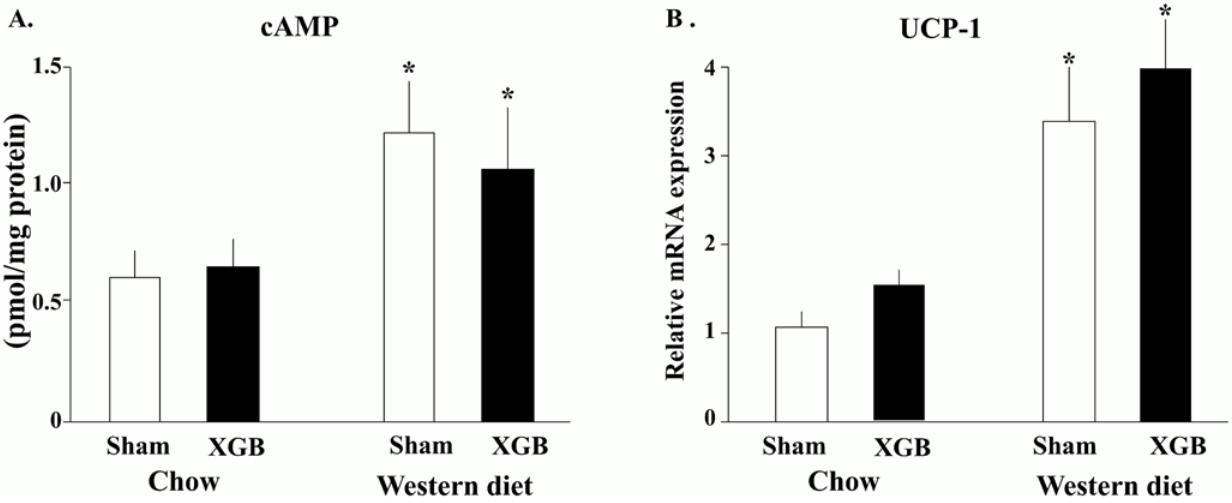
Fig 5. Effect of XGB on BAT cAMP concentration and mRNA expression levels of UCP-1 in wild type and Tgr5 -/- mice fed chow or WD diet. Forty to 45 days after XGB animals were sacrificed and tissue samples harvested as described in “ Methods ” . There were 4 to 8 animals per group. White bars represent sham — operated mice and black bars represent mice subjected to XGB. Values represent the mean ± S.E.M. * p < 0.001 compared to animals fed WD.